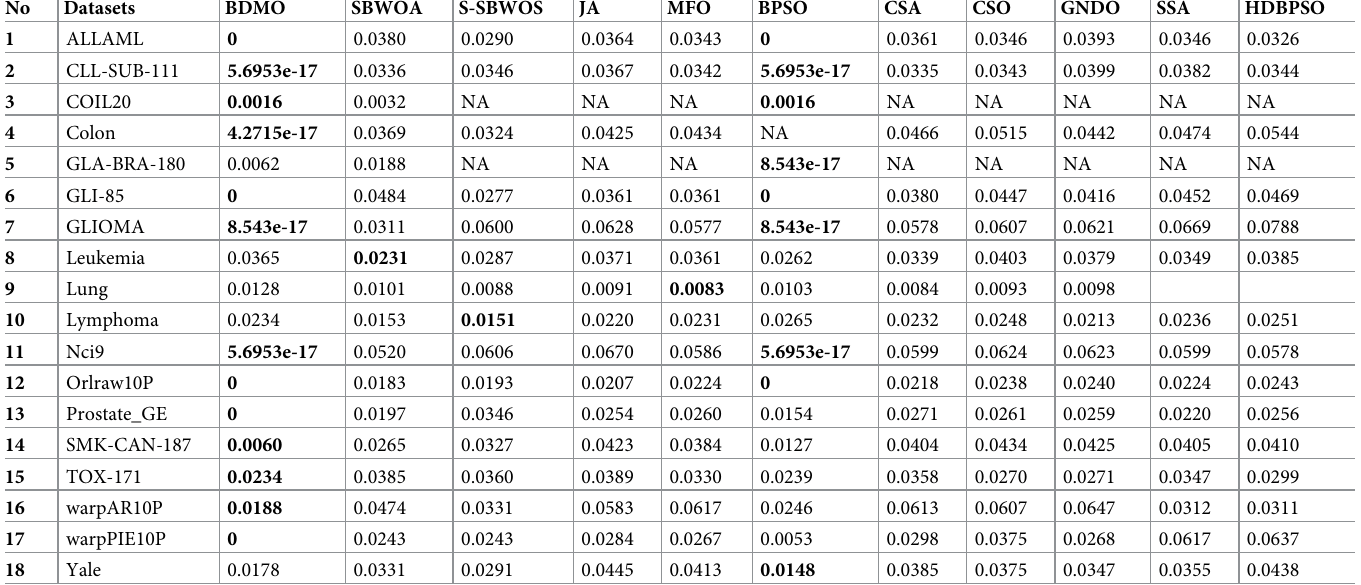
Table 4. Standard deviation of fitness